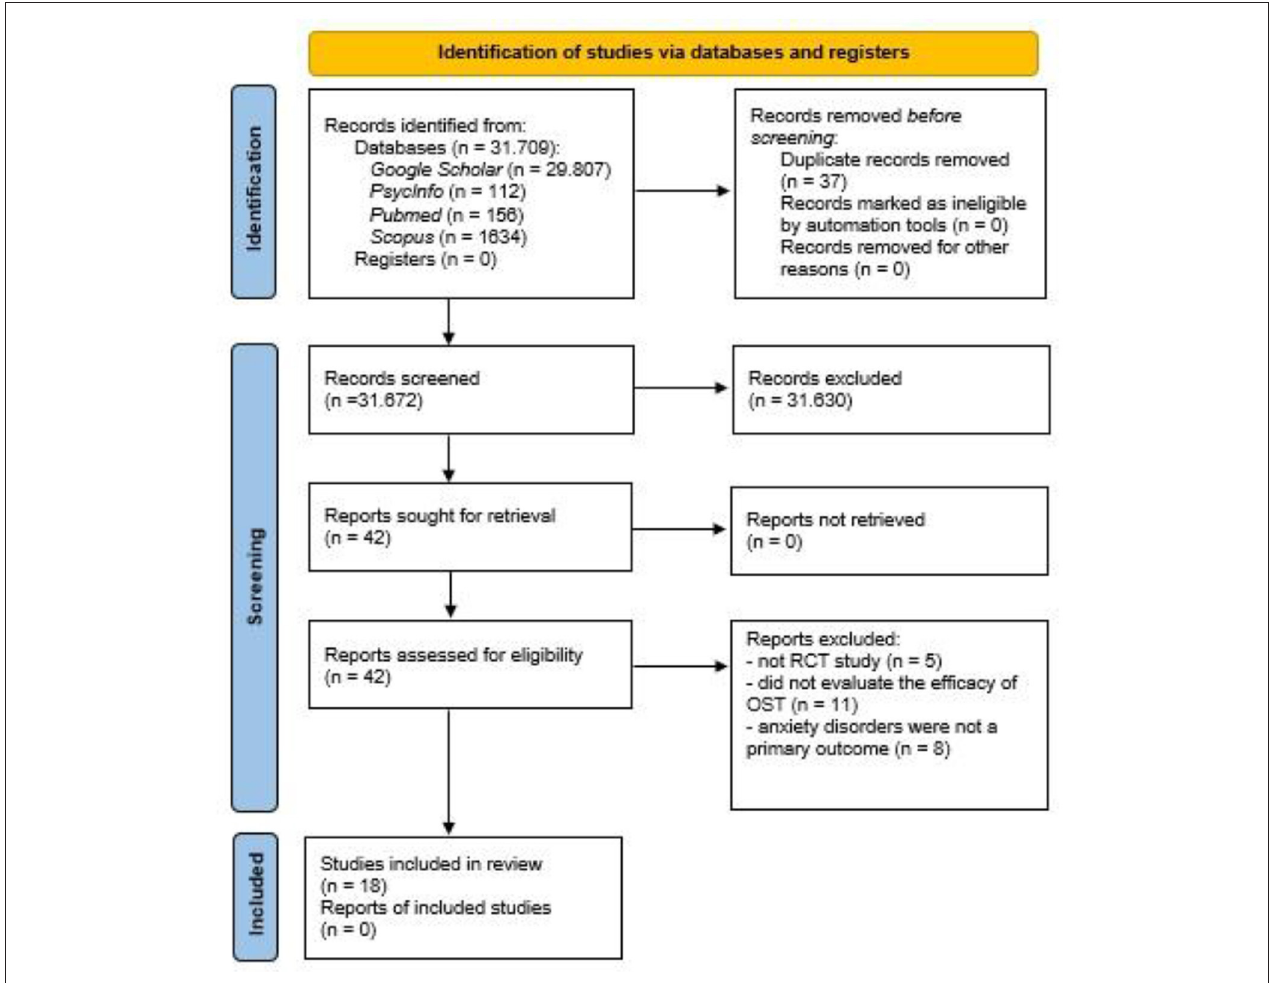
FIGURE 1 | PRISMA